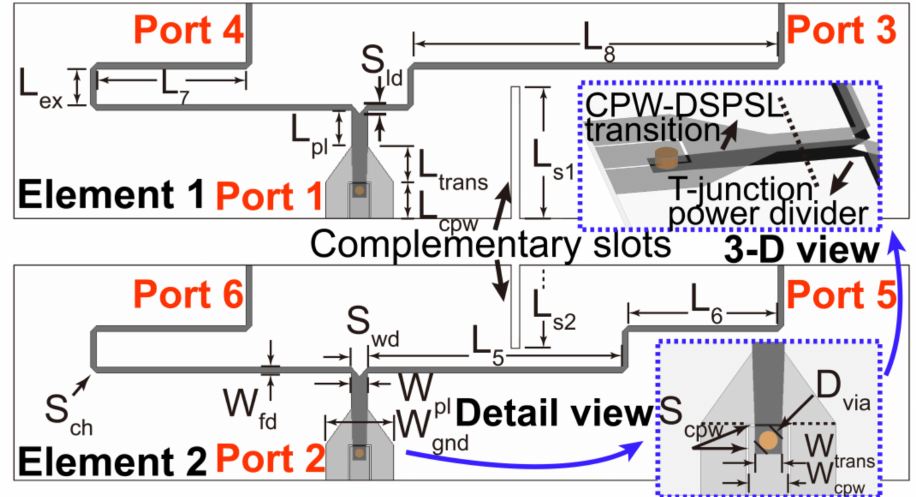
Figure 5. The configuration and dimension diagram of the balun-divider